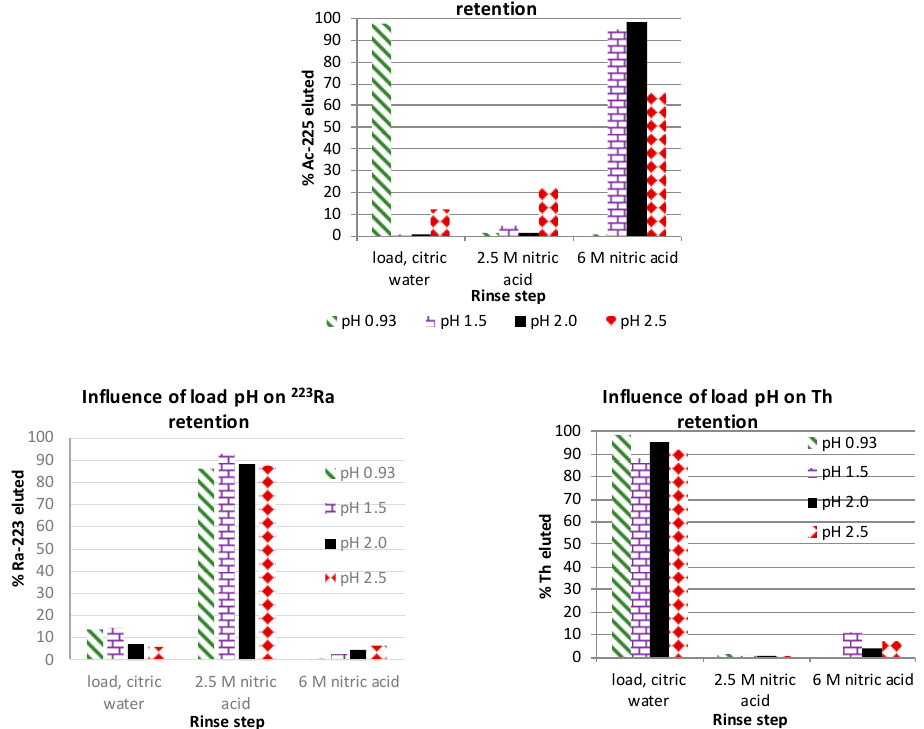
Figure 2. Influence of load pH on retention of 225 Ac, 223 Ra and 227 Th. Load solution = 0; rinse sequence: 3 mL of 1 M citric acid pH 2, water, 2 × 3 mL of water and 2 × 10 mL of 6 M nitric acid. 95%–98% of